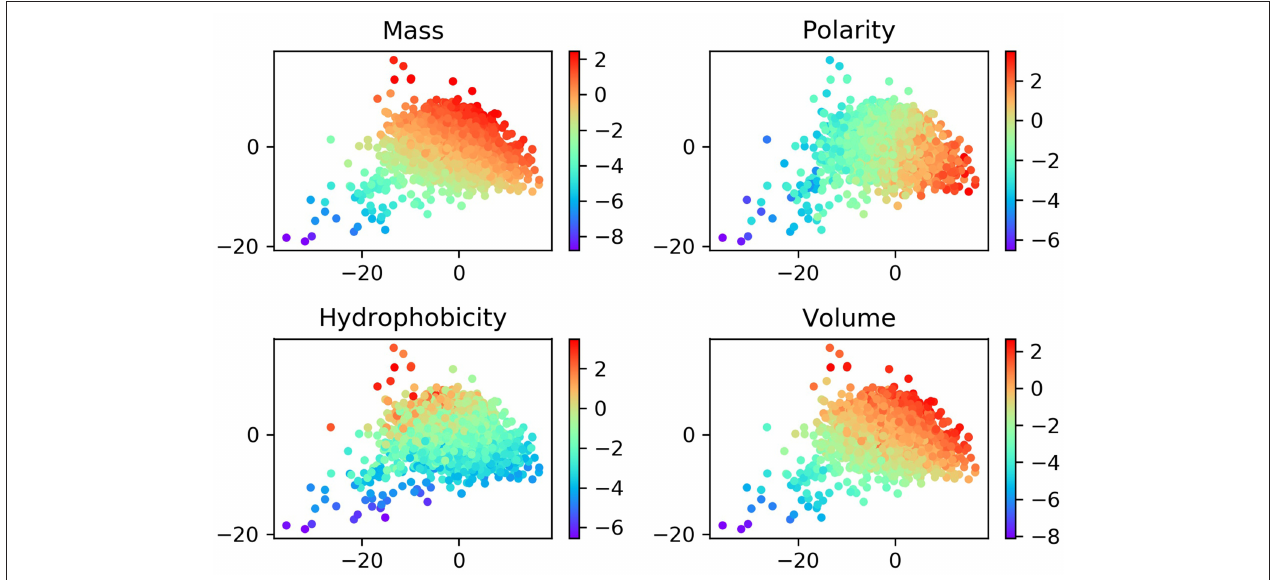
FIGURE 3 | Normalized distributions of biochemical and biophysical properties in a 2D space projected by t-SNE from the 100-dimensional ProtVec protein-space. In these plots, each point represents a protein, and the colors indicate the scale for each property.